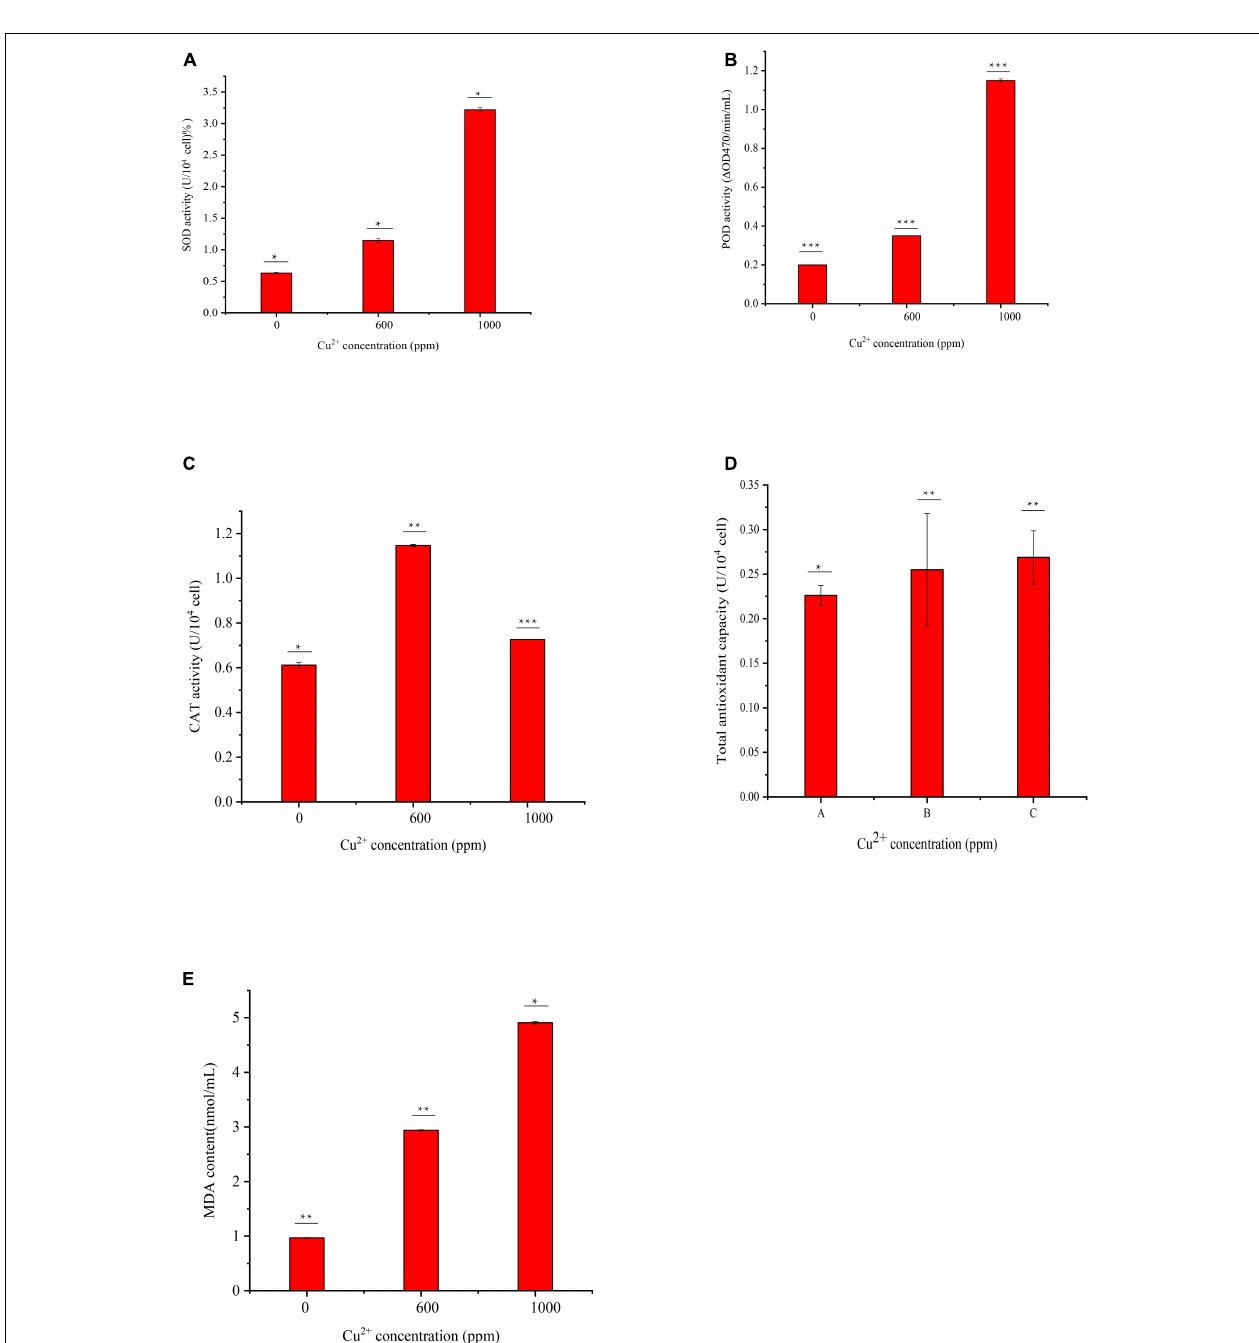
FIGURE 5 | Determination of antioxidant enzyme activities and MDA content of GXDK6 in different copper ion concentrations: (A) SOD activity, (B) POD activity, (C) CAT activity, (D) total antioxidant capacity, and (E) cell MDA content. All experiments were carried out three times, and standard deviation analysis was carried out on the data. * Means 0.01 < SD < 0.05, ** means 0.001 < SD < 0.01, and *** means SD <